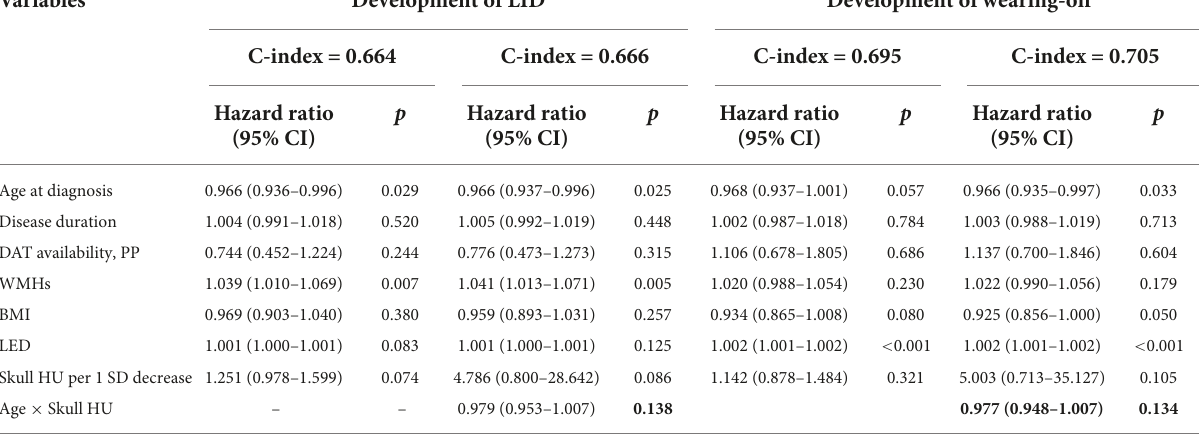
TABLE 3 Multivariate Cox hazard models for prediction of LID and wearing-off.